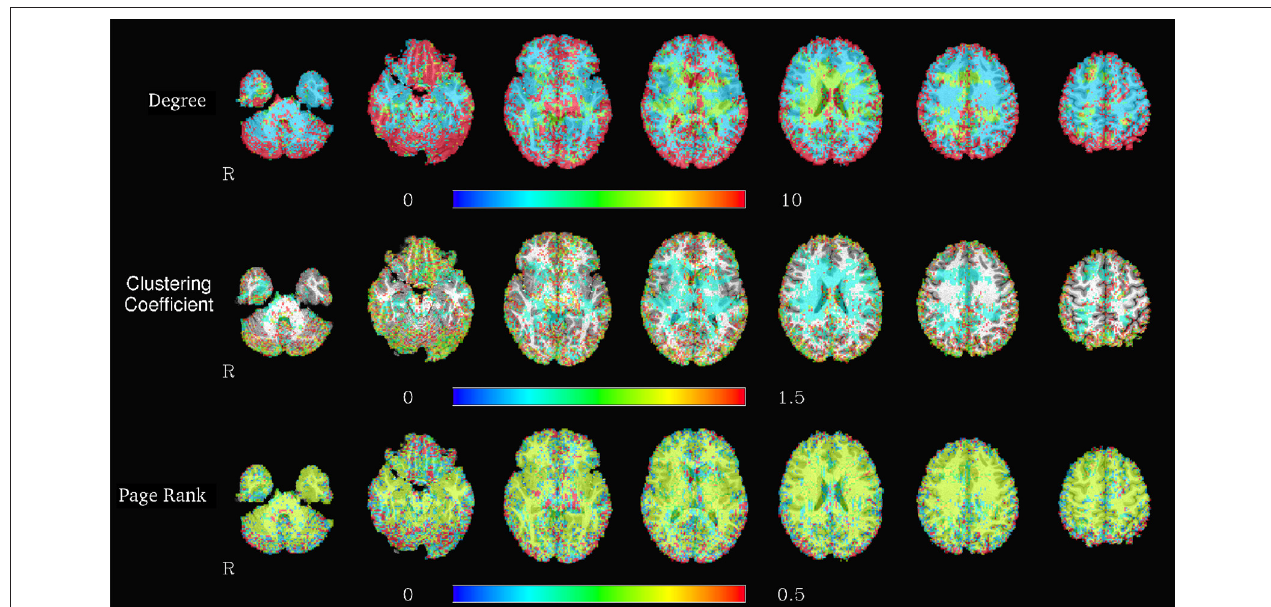
FIGURE 6 | Spatial distribution of node degrees (top), local clustering coefficients (center), and PageRank (bottom) at a voxelwise level for one representative subject, using the graph based on the correlation map thresholded at 0.6. In addition, the computation of correlation matrices from fMRI time series was implemented to run on GPUs and optimized for the 4D structure of time series fMRI